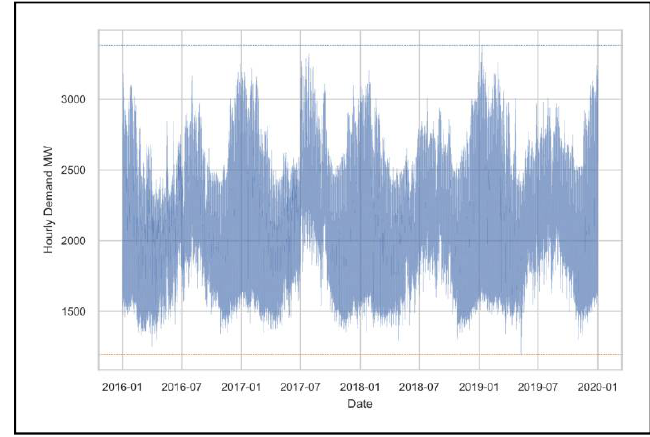
Figure 9. Yearly variation in Jordan’s electrical demand.